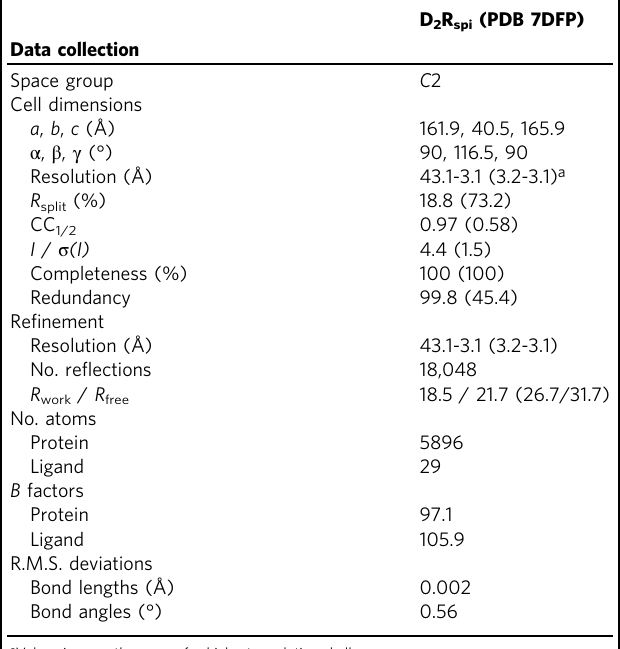
Table 1 Data collections and structure re fi nement